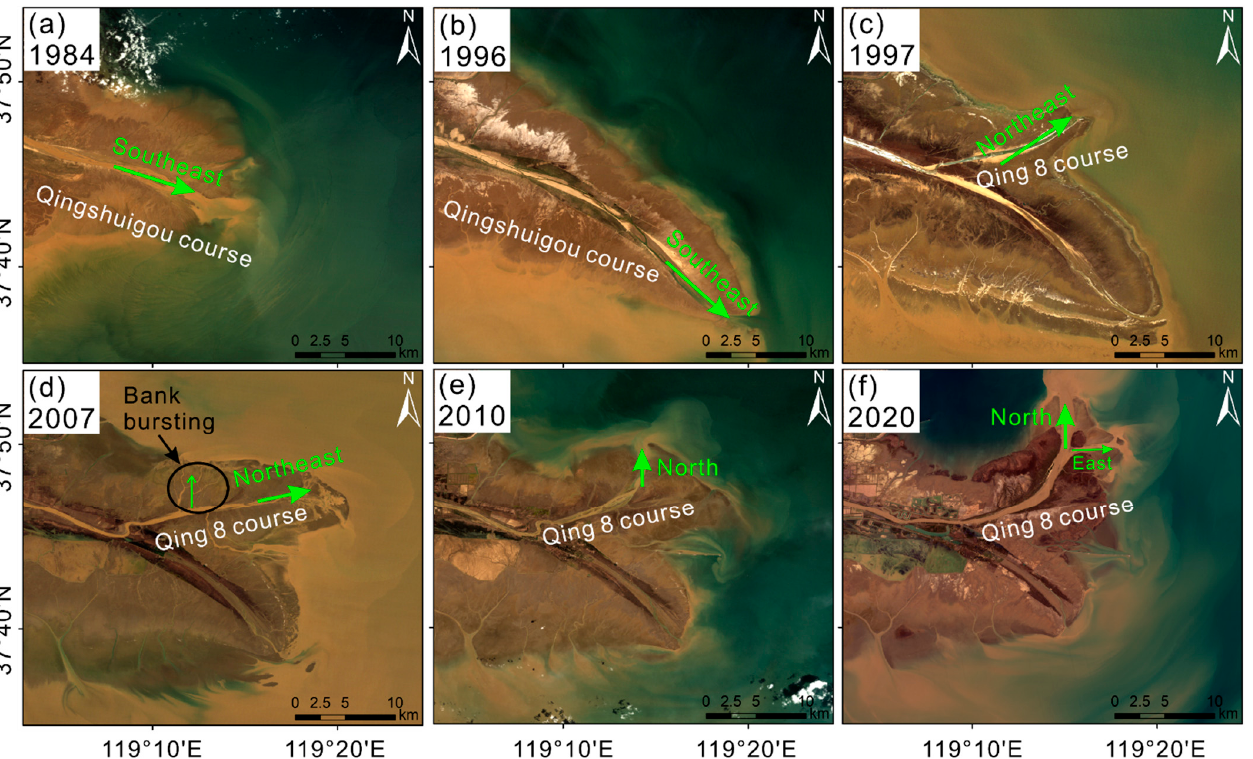
Figure 10. Morphology evolution of the Yellow River mouth at Qingshuigou and Qing 8 course. ( a – f ) indicate the status of the Yellow River mouth in 1984, 1996, 1997, 2007, 2010 and 2020, respectively. The green arrows indicate the direction in which the Yellow River entered the sea.